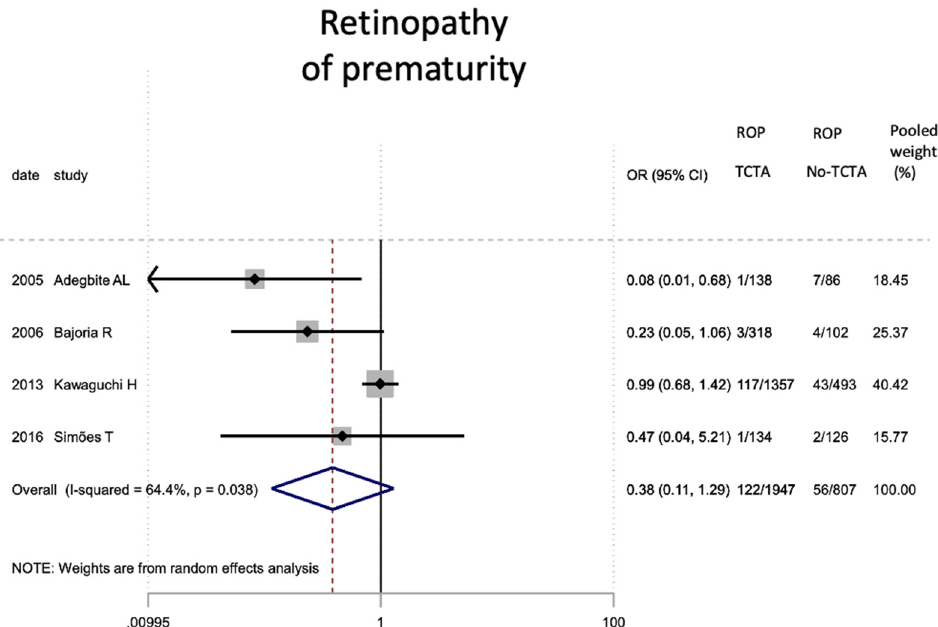
Figure 12. Results of the meta-analysis on the effect of chorionicity (TCTA vs no TCTA) on the development of retinopathy of prem-aturity. ROP: retinopathy of prematurity; TCTA: trichorial- triamniotic, non-TCTA: non-trichorial-triamniotic. OR = odds ratio, CI = confidence interval.